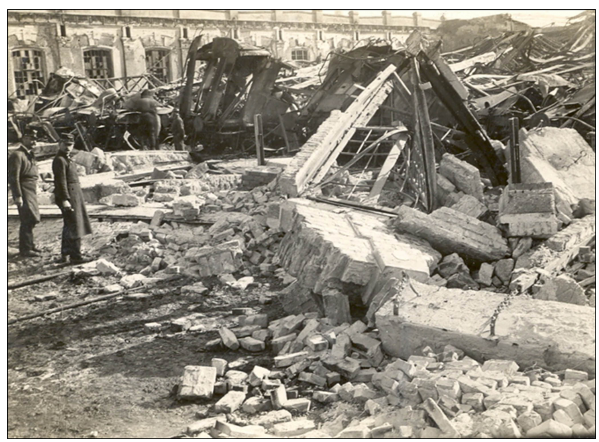
Figure 4. F4 destruction on the plot of the old locomotive factory. Photo taken from a private archive in Wiener Neustadt.